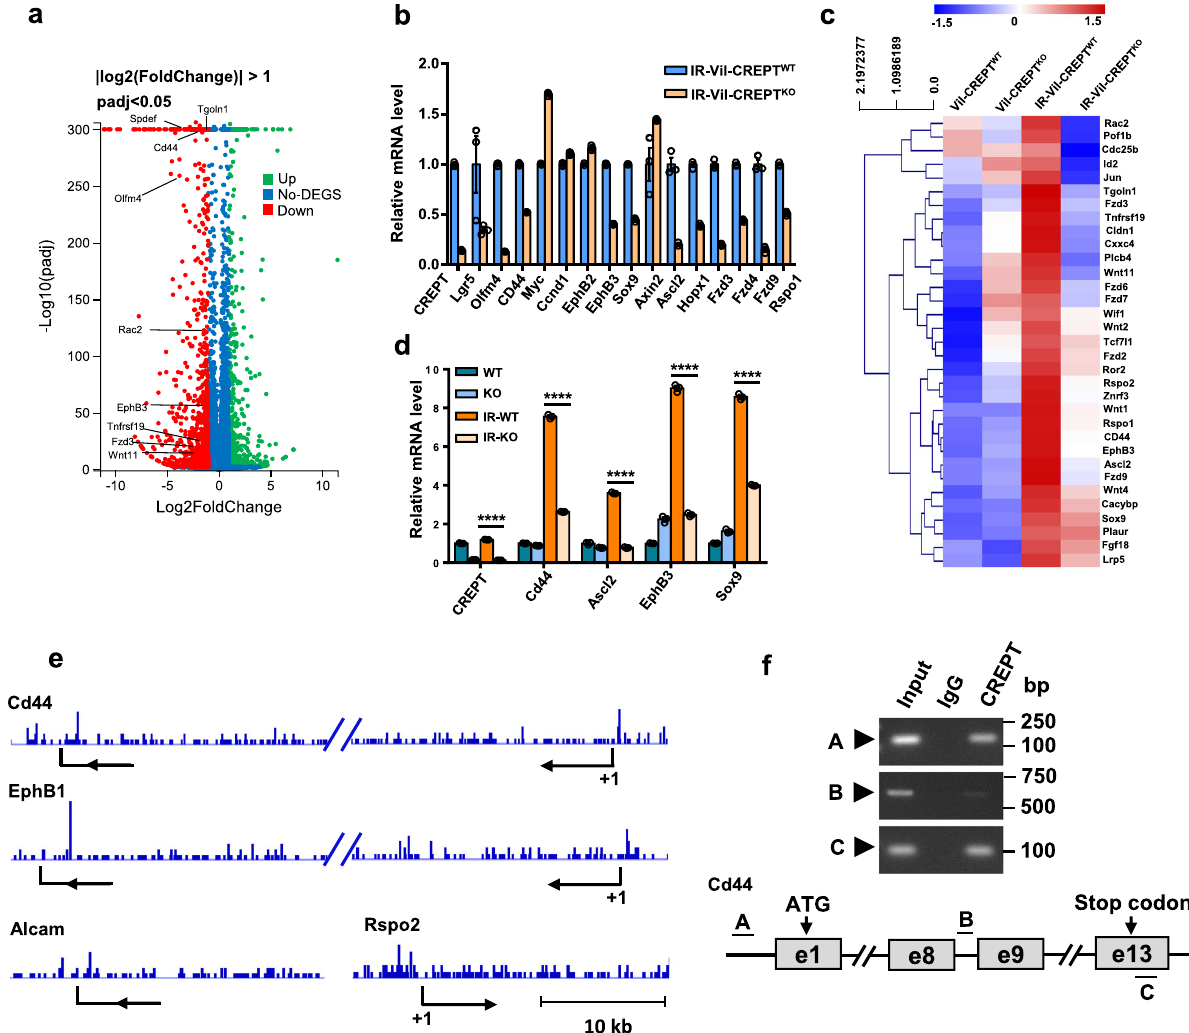
Fig. 5 CREPT promotes intestinal regeneration through the Wnt signaling pathway. a Volcano plot showing the upregulated and downregulated genes in irradiated (IR)-Vil-CREPT KO crypts compared to IR-Vil-CREPT WT ones. b Quantitative RT-PCR analysis of Wnt target genes in irradiated WT and Vil- CREPT KO intestines at 3 dpi. n = 3 independent experiments. c Heatmap showing the expression levels of Wnt target genes in untreated/irradiated WT and Vil-CREPT KO intestines. d Quantitative RT-PCR analysis of Cd44 , Ascl2 , EphB3 , and Sox9 expression in untreated/irradiated WT and Vil-CREPT KO intestines. p < 0.0001 by 2-tailed Student ’ s t -test. n = 3 independent experiments. e ChIP-seq signals of CREPT occupied genomic loci. The CREPT occupancy frequency is illustrated at the genome of Wnt target genes including Cd44 , EphB1 , Alcam , and Rspo2 . f Quantitative PCRs showing the enrichment of CREPT on the promotor and termination region of the Cd44 gene. The primers A, B, and C, were designed as indicated. Images are representative of three independent experiments. Statistics data represent mean ±